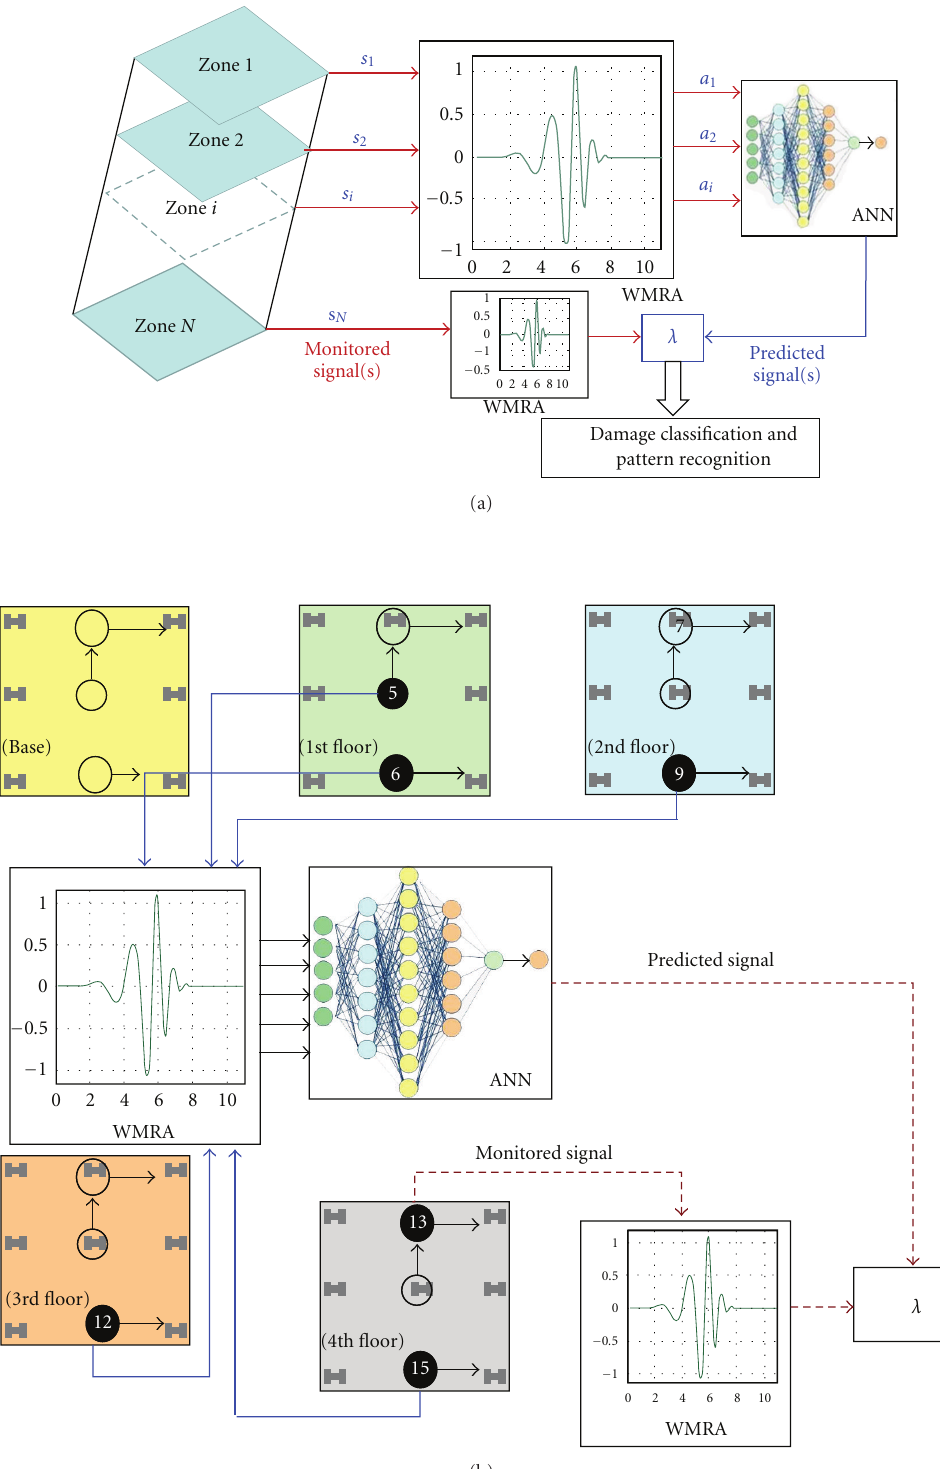
Figure 3: Schematic representation of the neural-wavelet damage detection method (a) general application of method to any structure divided to N zones (b) specific method application for damage detection in the ASCE benchmark structure (damage feature λ